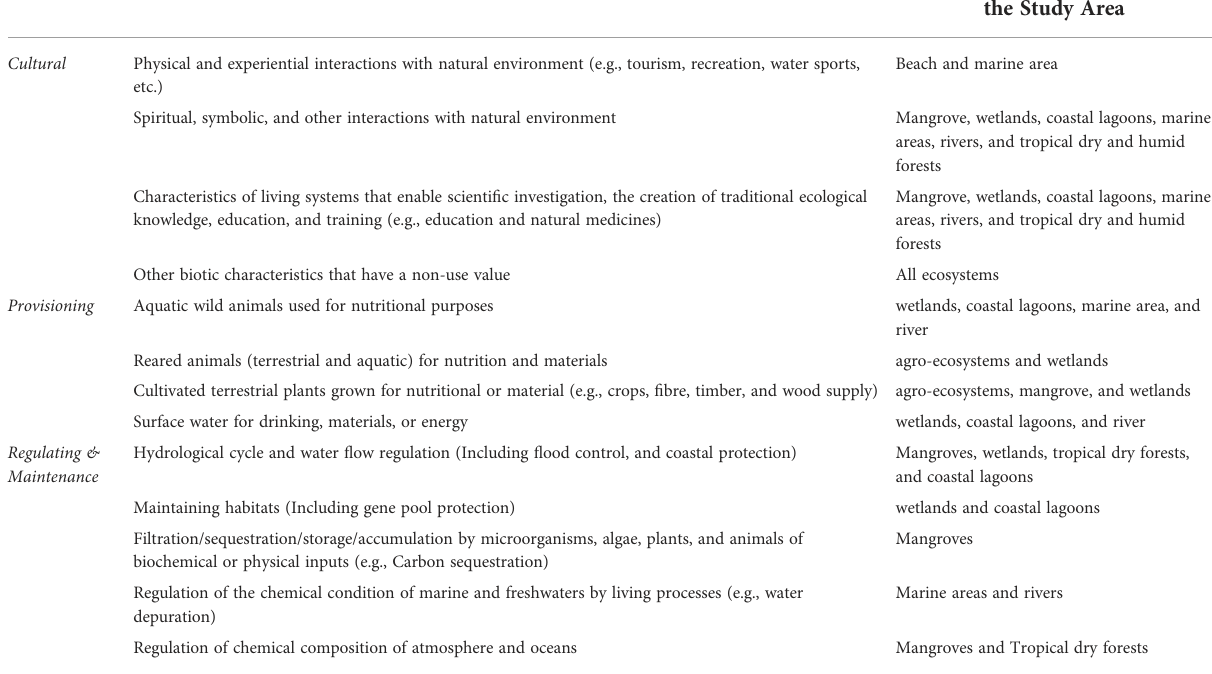
TABLE 4 Ecosystem services in the study